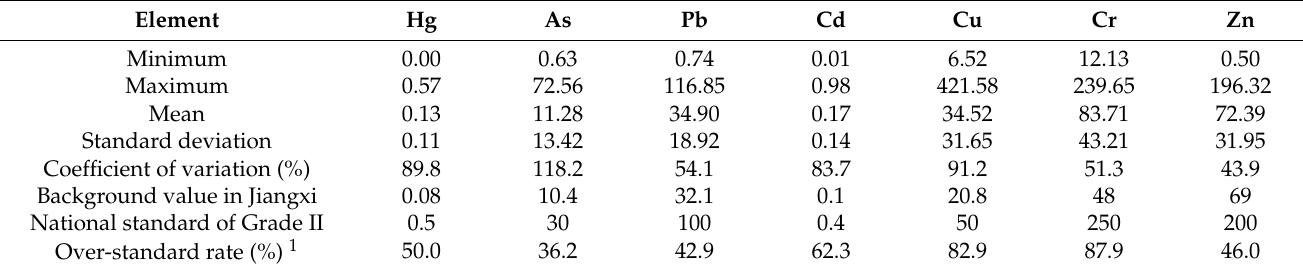
Table 2. Descriptive statistics of potential toxic elements concentrations in cultivated soils in the study region